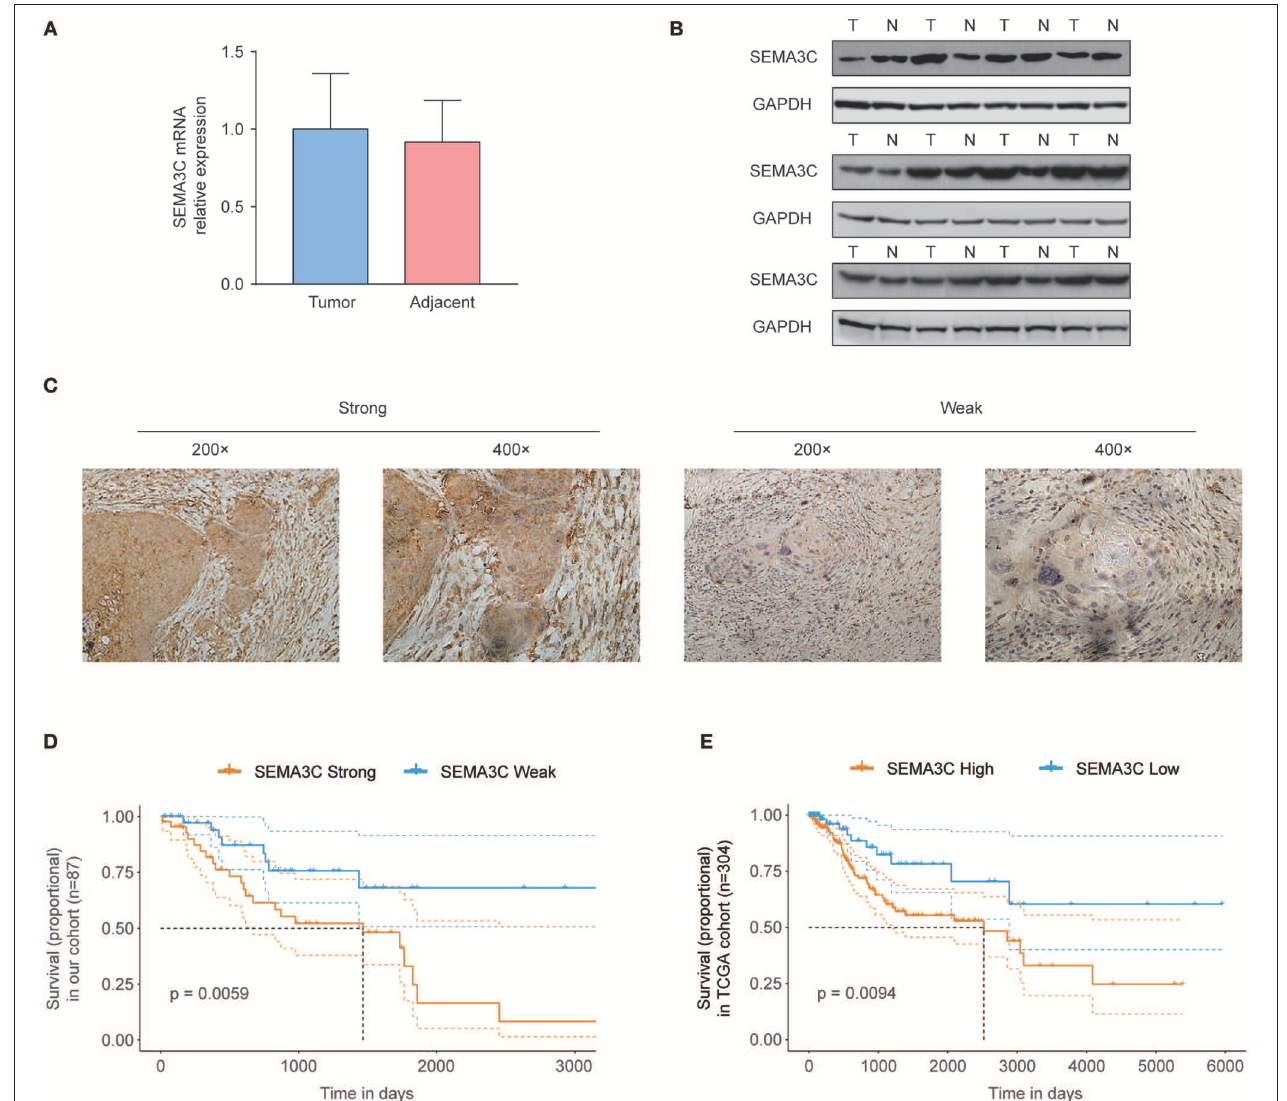
FIGURE 1 | SEMA3C predicts poor prognosis of cervical cancer patients. (A) Real-time PCR analysis of SEMA3C expression in 12 pairs of cervical cancer tissues and adjacent normal tissues. (B) Western blot assay of SEMA3C expression in cervical cancer tissues (T) and paired adjacent normal tissues (N) from 12 patients. (C) Immunohistochemical staining and scoring of SEMA3C expression was performed in 87 human cervical cancer samples. Representative views were shown. (D) Kaplan–Meier analysis results for overall survival correlation with SEMA3C expression assessed by immunohistochemical staining in our cohort are presented. The patients were divided into two groups according to the median value. (E) Kaplan–Meier analysis results for overall survival correlation with SEMA3C expression assessed by sequencing in the TCGA cohort are presented. High SEMA3C group, n = 201; low SEMA3C group, n = 103. The patients were divided into two groups according to the cutoff representing the value that yields maximal difference with regard to survival at the lowest log-rank P -value calculated by R software. The dotted lines indicate 95% confidence intervals. T, tumor tissue; N, adjacent normal